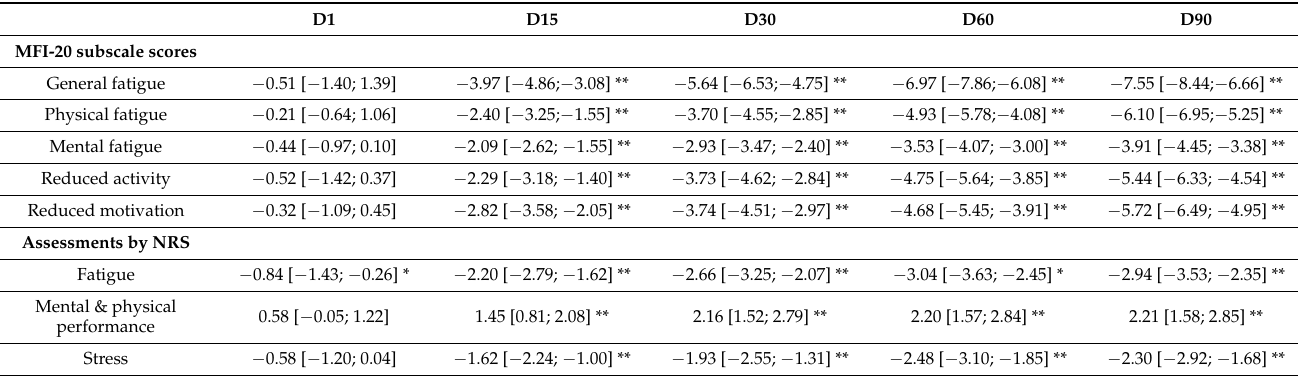
Table 2. Mean differences (expressed in arbitrary units) between baseline and post baseline visit of MFI subscale scores and numerical rating scores for fatigue, performance, and stress at different times of supplementation with a vitamin and mineral supplement containing Panax ginseng extract (G115 ® ) ( n =